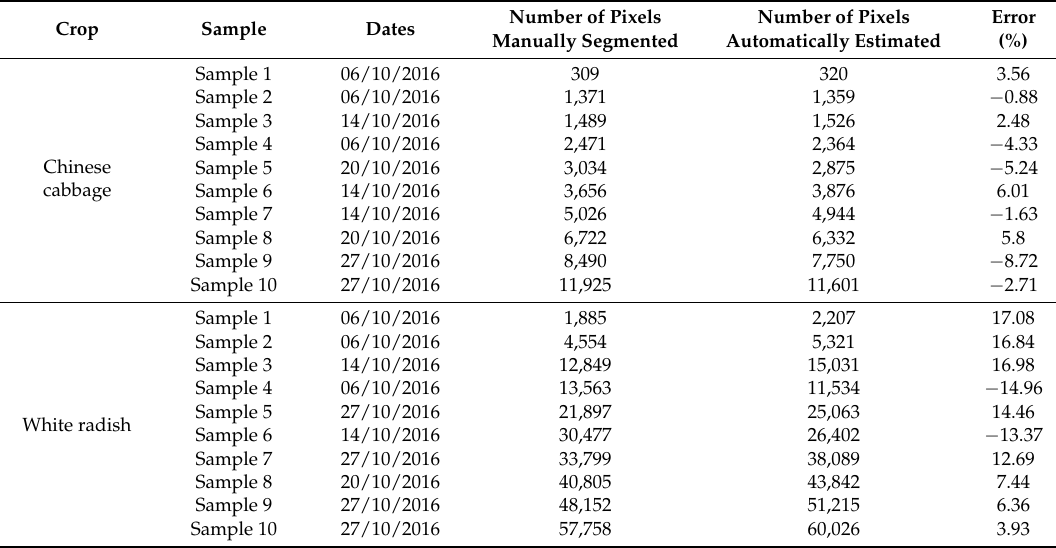
Table 5. Results of crop segmentation performance obtained using the Otsu threshold and excess green (ExG) vegetation index.